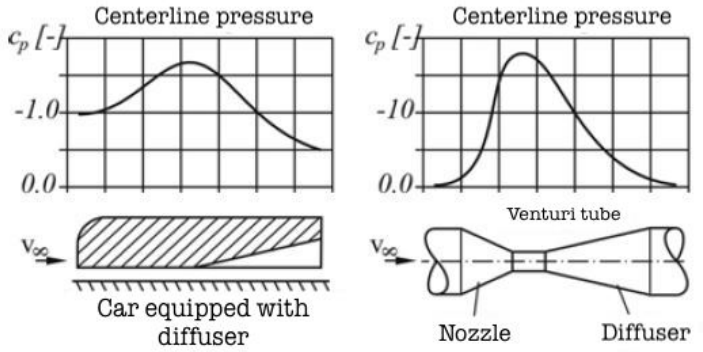
Figure 2. Pressure distribution along the centreline of a generic body of car with an underbody diffuser and a Venturi tube.